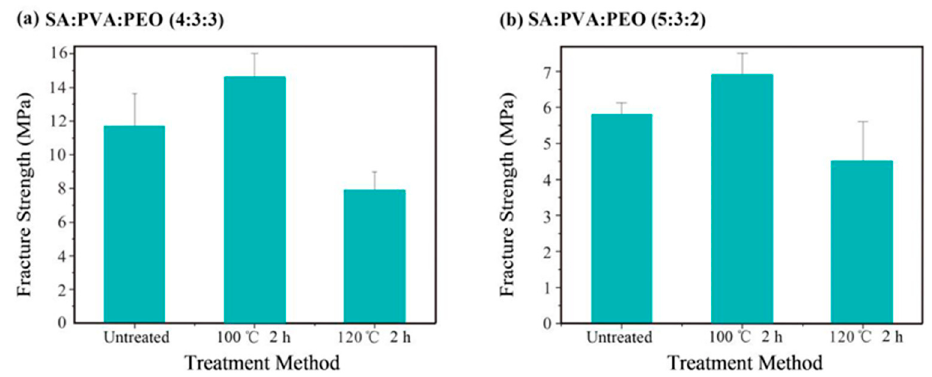
Figure 5. Surface morphological structure of SA/PVA/PEO 4:3:3 MFMs treated at ( a ) 100 °C and ( b ) 120 °C. ( c ) Average diameter of SA/PVA/PEO 4:3:3 MFMs treated at different temperatures. Surface morphological structure of SA/PVA/PEO 5:3:2 MFMs treated at ( d ) 100 °C and ( e ) 120 °C. ( f ) Average diameter of SA/PVA/PEO 5:3:2 MFMs treated at different temperatures.